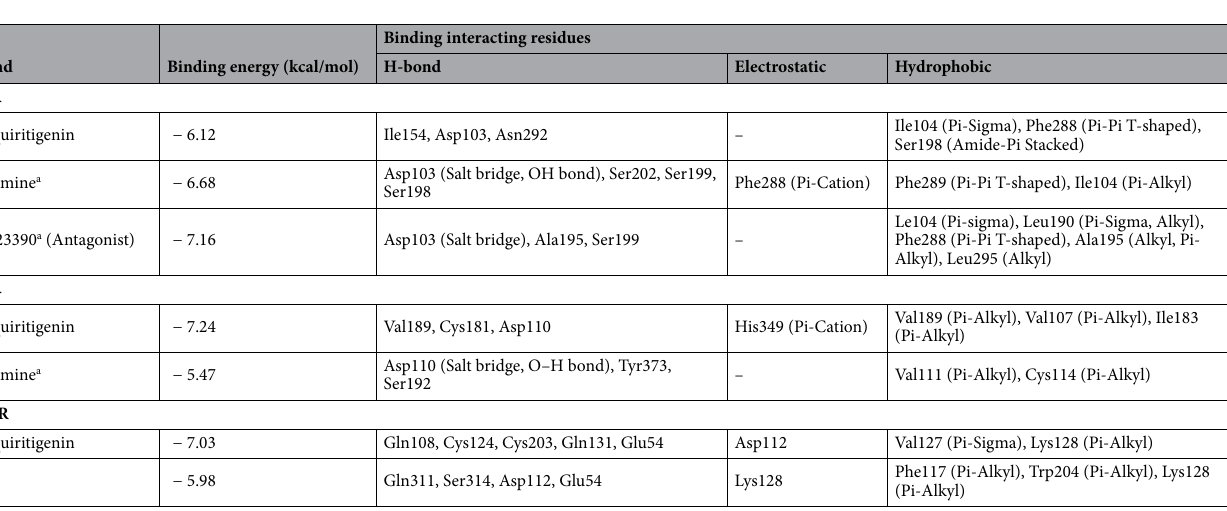
Table 5. Binding energy and interacting residues of isoliquiritigenin and reference ligands at the active sites of human dopamine and vasopressin receptors (hD 1 R, hD 3 R, and hV 1A R). a Reference ligands for hD 1 R, hD 3 R, and hV 1A